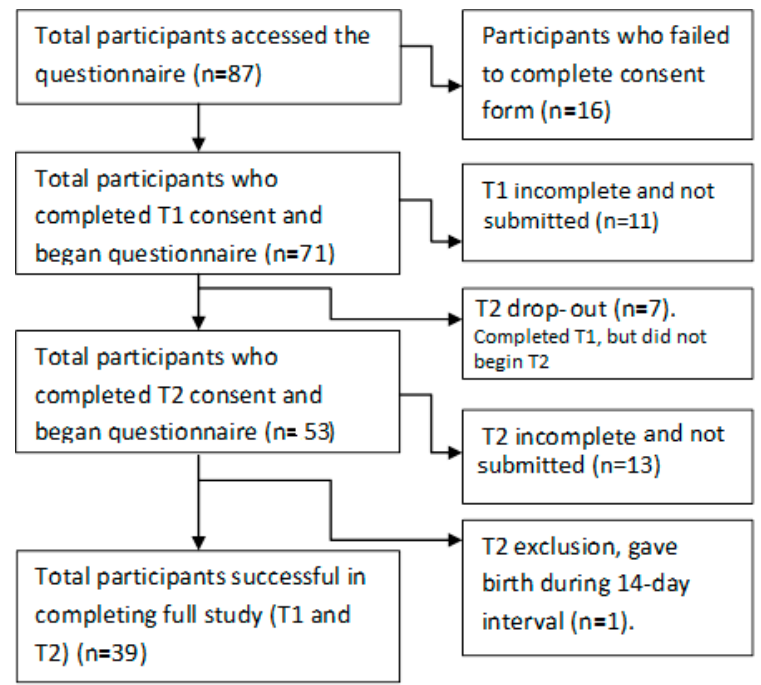
Figure 1 . Outline of participants in each phase of test-retest validation study (participation rate); T1 = test 1, T2 = re-test 2.